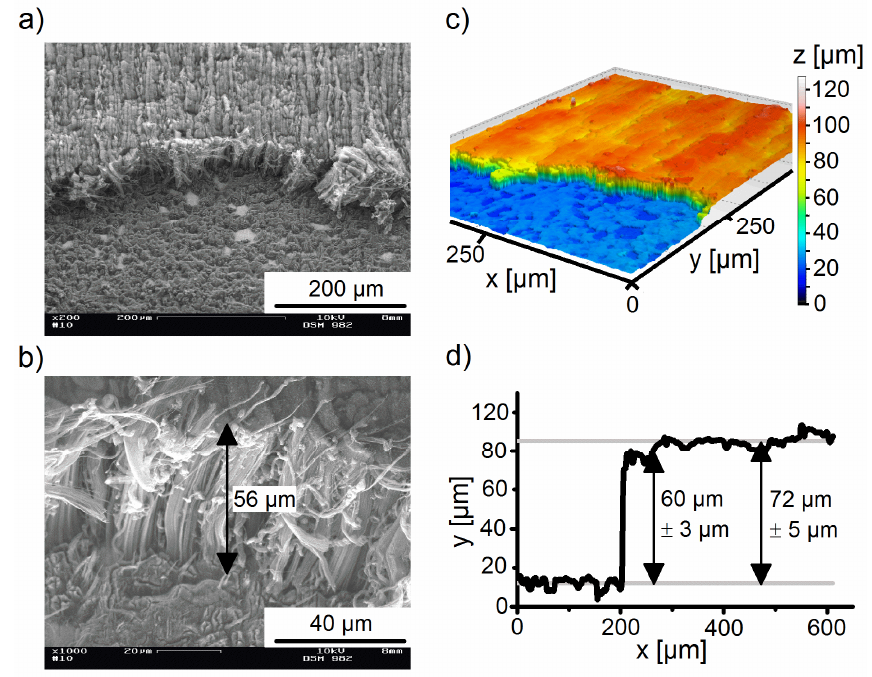
Figure 2. SEM images of a VACNT sample on nickel foil with Al 2 O 3 buffer layer (20 nm) and Fe x Co y O z catalyst layer (40 nm) with lower ( a ) and higher ( b ) magnification. For SEM-based height determination a correction factor of 2 has to be applied, due to specimen tilting. Confocal microscopy topography image of the same sample ( c ) and vertical profile extracted from confocal microscopy image ( d